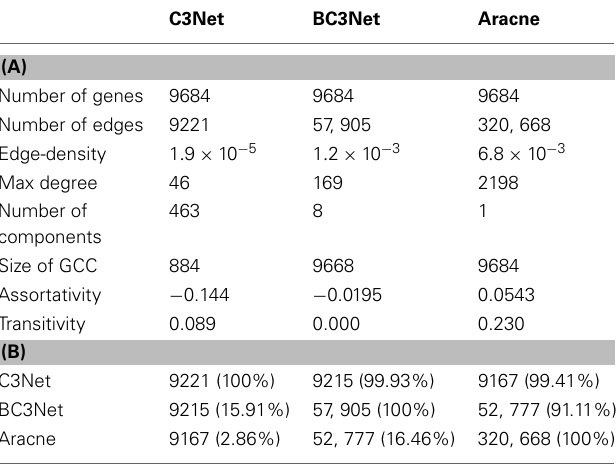
Table 1 | (A) Global network properties of the B-cell lymphoma C3Net, BC3Net and Aracne GRN. (B) Edge-overlap between the 3 GRN.